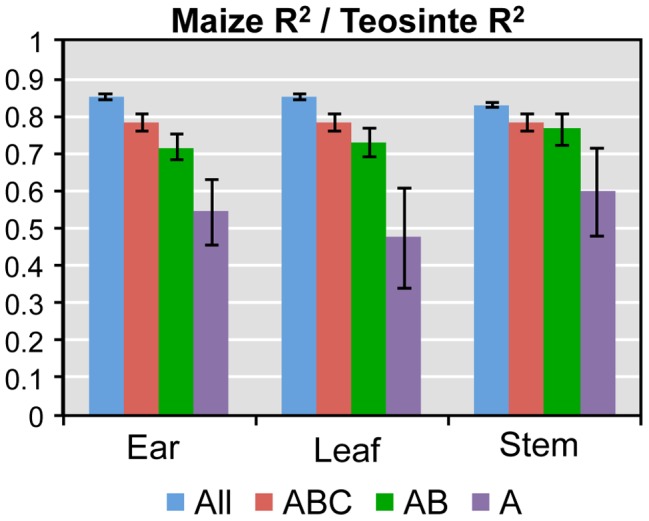
Ratio of the average maize to teosinte R2 values for individual genes from models explaining hybrid expression by maize and teosinte parent.In all three tissues, the proportion of maize to teosinte R2 decreases in candidate CCT gene lists with the strongest candidates (CCT-A) having the most extreme reduction in variation in maize relative to teosinte. Error bars indicate ± one standard error.